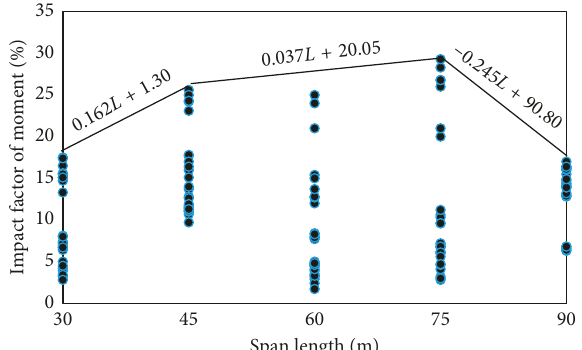
Figure 12: Shear force dynamic impact factor versus span